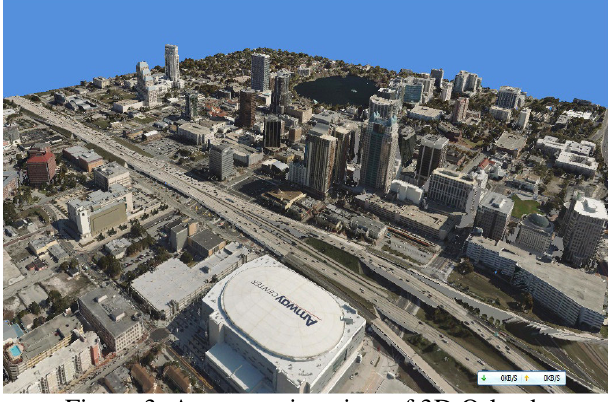
Figure 3. A perspective view of 3D Orlando